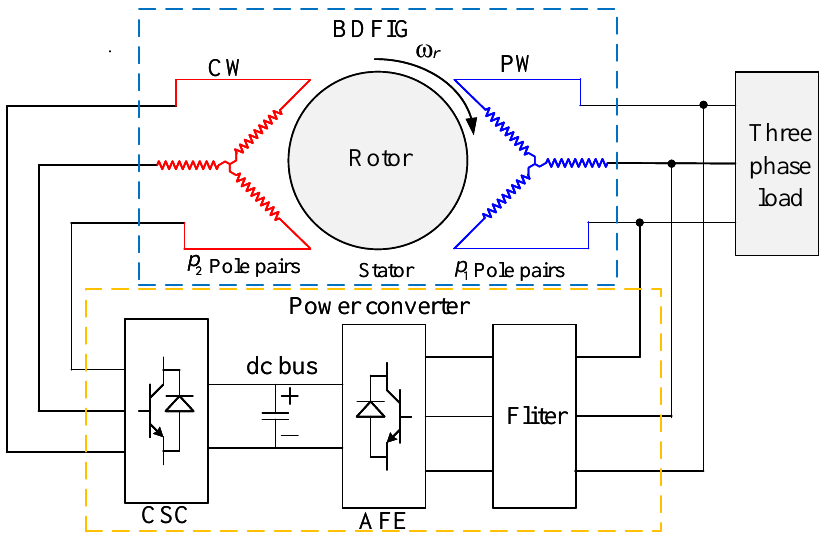
Figure 1. The structure of the BDFIG in the ship power mircogrid, where the SCS means the CW-side converter and the AFE means the active front